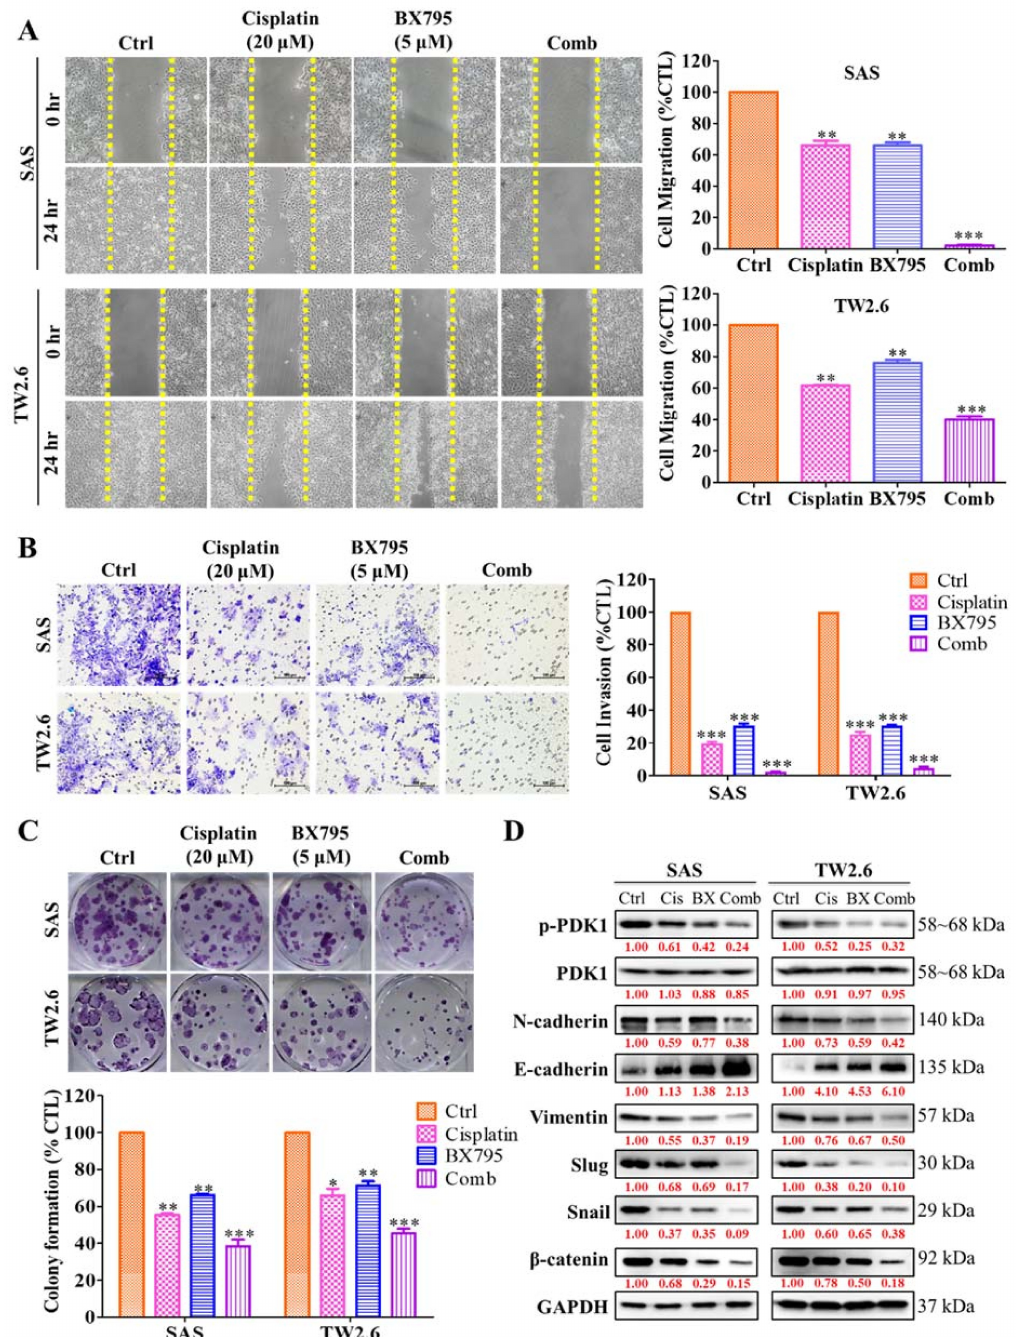
Figure 5. The combination of cisplatin and BX795 reduces OSCC cell migration, invasion, and colony formation. ( A ) A representative image of the scratch-wound migration assay shows the inhibitory effect of cisplatin, BX795, or their combination on the motility of SAS and TW2.6 cells at 24 h. ( B ) Representative images of SAS and TW2.6 cells invasion capabilities after treatment with cisplatin, BX795, or their combination. ( C ) Representative images of colonies formed by SAS and TW2.6 cells after treatment with cisplatin, BX795, or their combination in the culture plate were observed using crystal violet solution staining. ( D ) The inhibitory effect of cisplatin, BX795, or their combination on the expression of PDK1, p-PDK1, Vimentin, Slug, Snail, N-cadherin, E-cadherin and β -catenin in SAS and TW2.6 cells, as demonstrated by western blot analyses. GAPDH served as a loading control. All data are representative of the experiment conducted four times in triplicate and are expressed as mean ± SD * p < 0.05, ** p < 0.01, *** p < 0.001; scale bar 100 µ